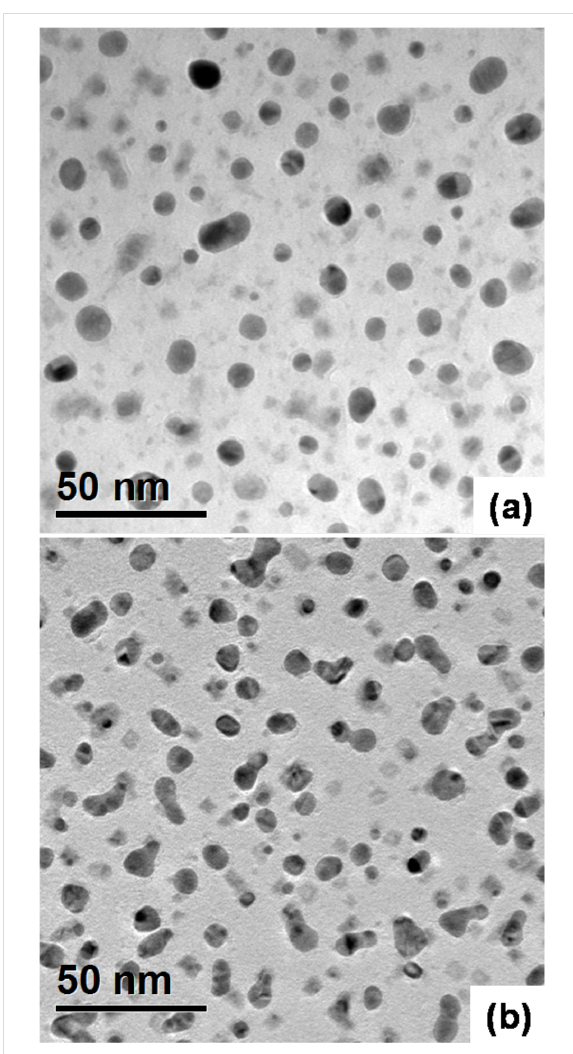
Figure 1: Plan view TEM micrographs of AuNPs electroless deposited on a Si substrate by immersion for 3 s in the solution after a DHF pretreatment of 240 s; sample preparation (a) standard high energy and (b) gentle milling